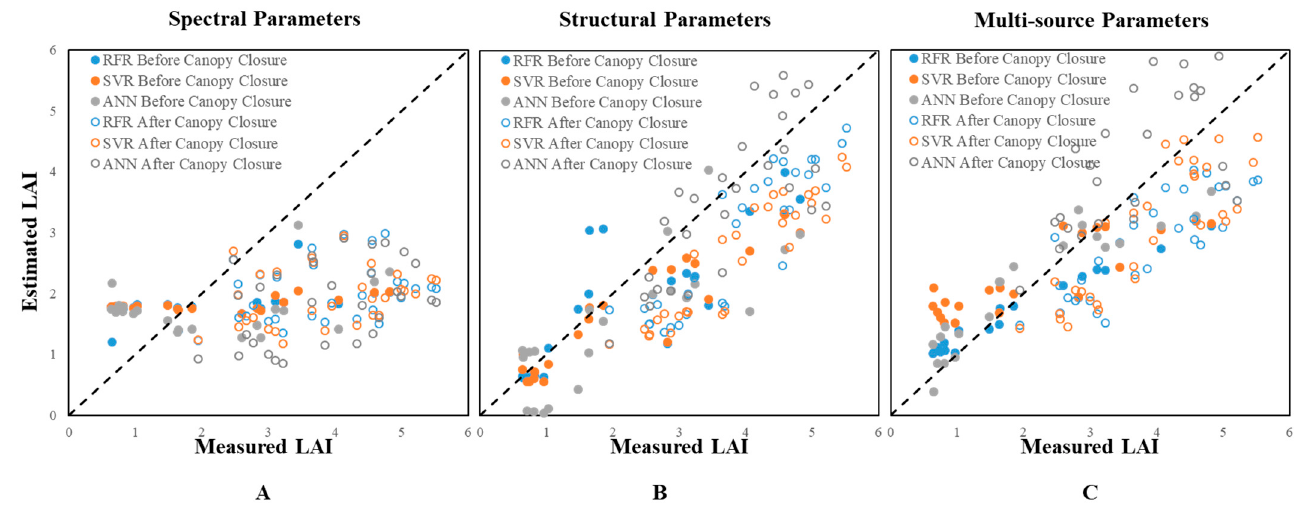
Figure 10. Relationship between the estimated LAI and measured values of three machine learning models based on different input parameters before and after canopy closure, where ( A ) represents machine learning models based on the spectral parameters, ( B ) represents machine learning models based on the structural parameters and ( C ) represents machine learning models based on the multisource parameters (note: the black dotted line is a 1:1 line).